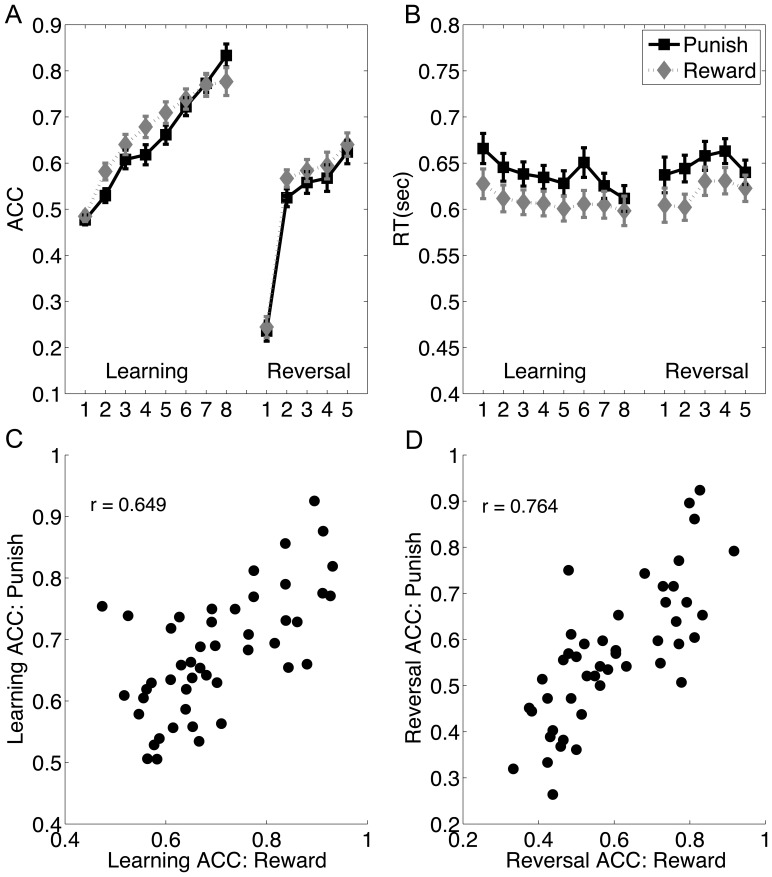
Behavioral results.The averaged accuracy (A) and reaction time (B) for each repetition during initial acquisition and reversal were plotted, separately for reward and punishment conditions. Error bars indicate one standardized error (SE). The scatter plots show the correlation of performance (accuracy) between reward and punishment during initial acquisition (C) and subsequent reversal learning (D).